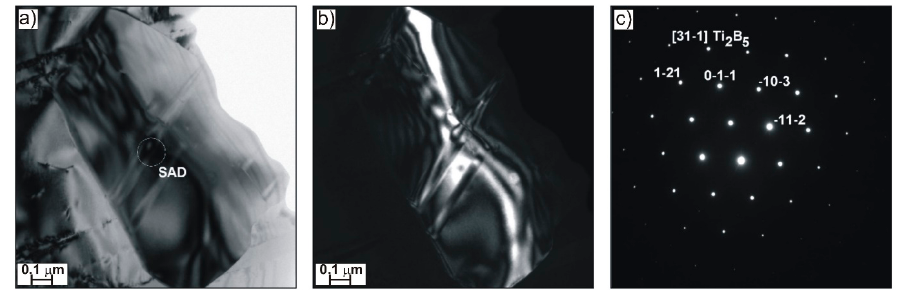
Figure 4. Ti 2 B 5 phase precipitates in Ti–45Al–8Nb–0.5(B, C) alloy: bright field ( a ), dark field ( b ), and electron diffraction ( c ).